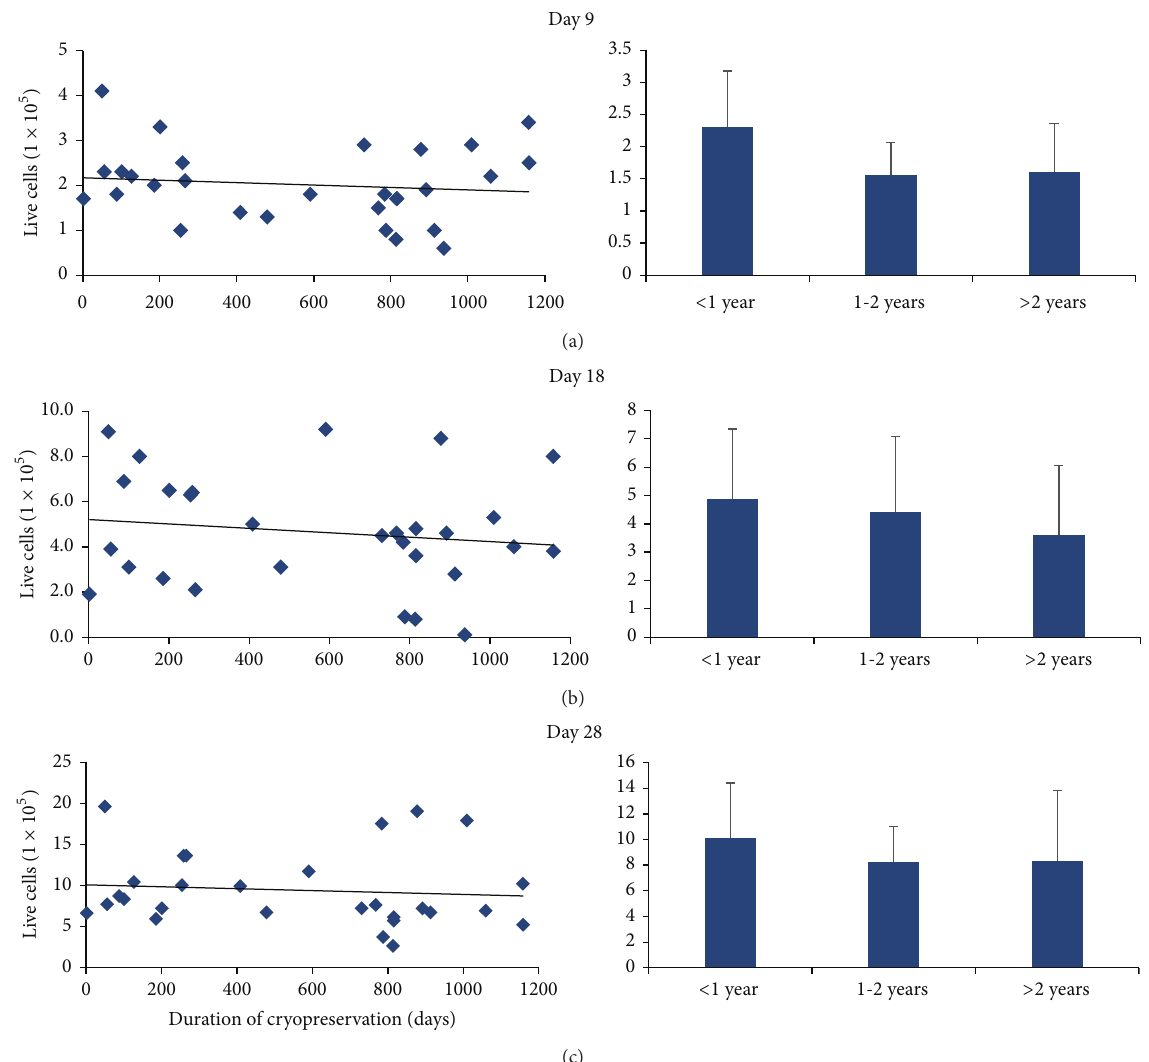
Figure 3: Live ASCs during extended cell growth relative to cryopreservation duration. ASCs from each patient were plated to a density of 1 × 10 5 cells/well and counted after (a) 9, (b) 18, and (c) 28 days to characterize the effect of cryopreservation duration on continued ASC growth.WeobservedsustainedASCgrowthirrespectiveofcryopreservationduration.Cellcountswerecomparedrelativetocryopreservation duration in 3 cohort groups: < 1 year ( 𝑁 = 10 ), 1-2 years ( 𝑁 = 5 ), and > 2 years ( 𝑁 = 17 ), and were not found to be significantly